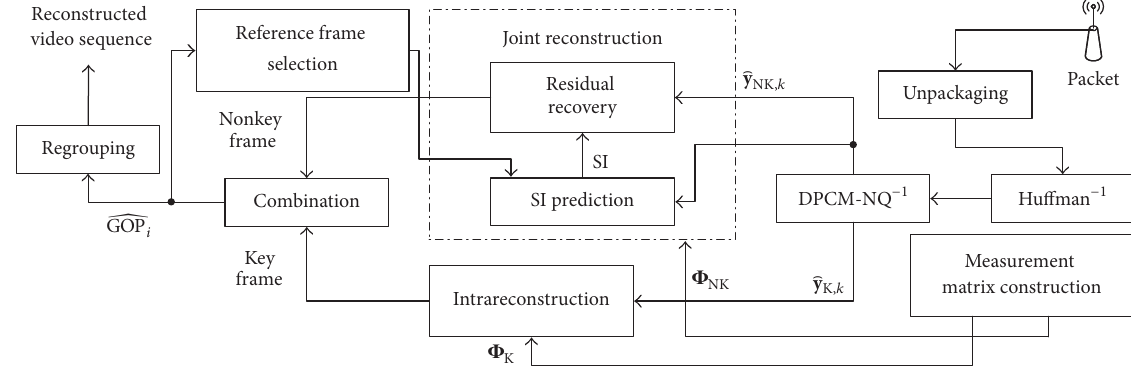
Figure 4: CSVC decoder